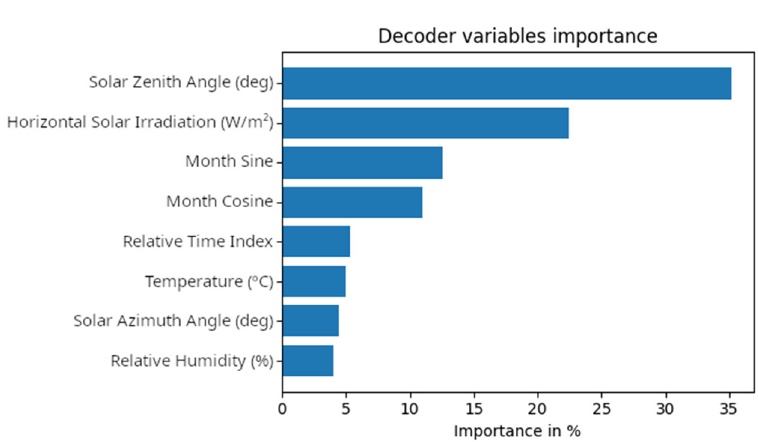
Figure 13. Importance of decoder variables.